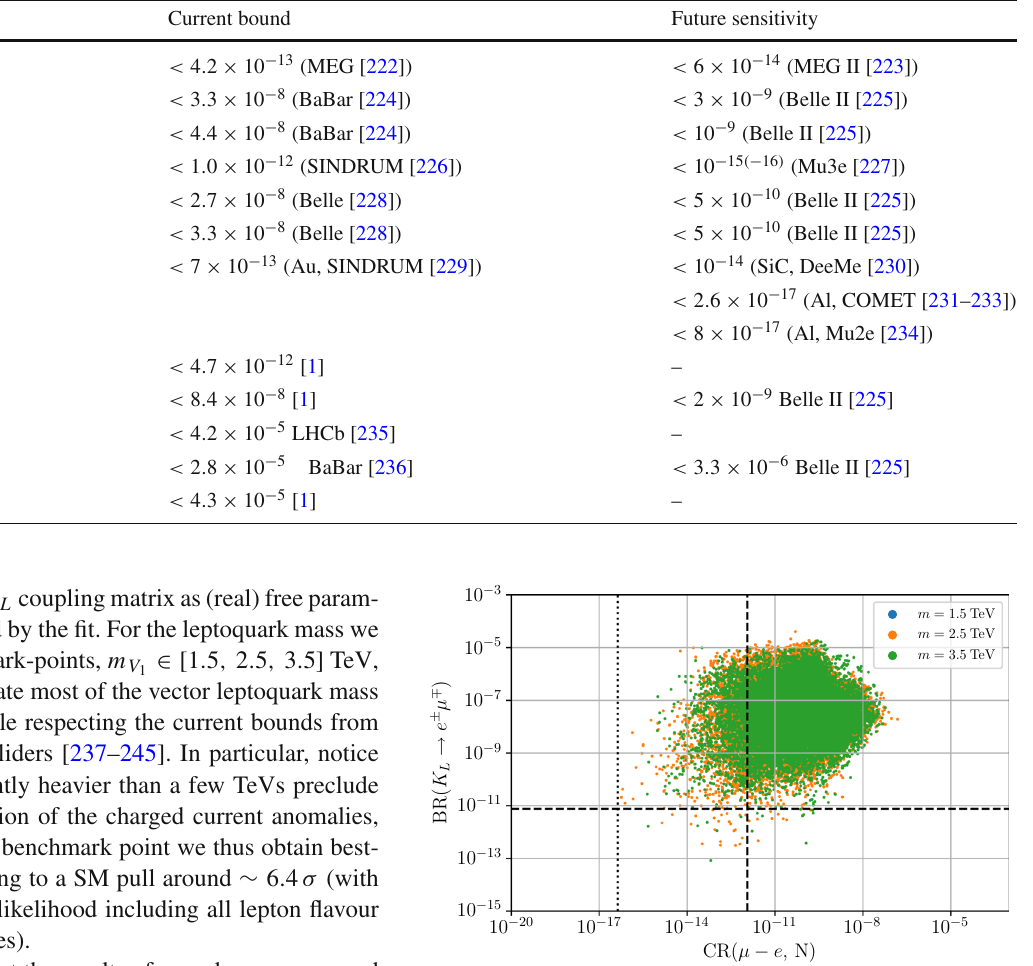
of the global fit, and now directly include the upper bounds from CR (μ − e , Au ) and BR ( K L → e ± μ ∓ ) as inputs in the fitting procedure for the vector leptoquark